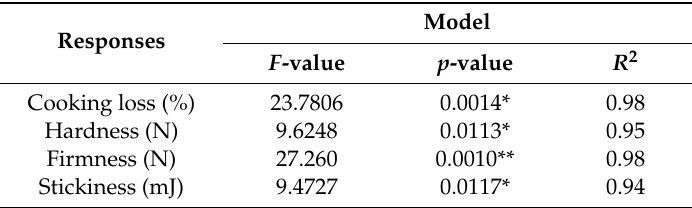
Table 2. F -values and coe ffi cient of determination for di ff erent